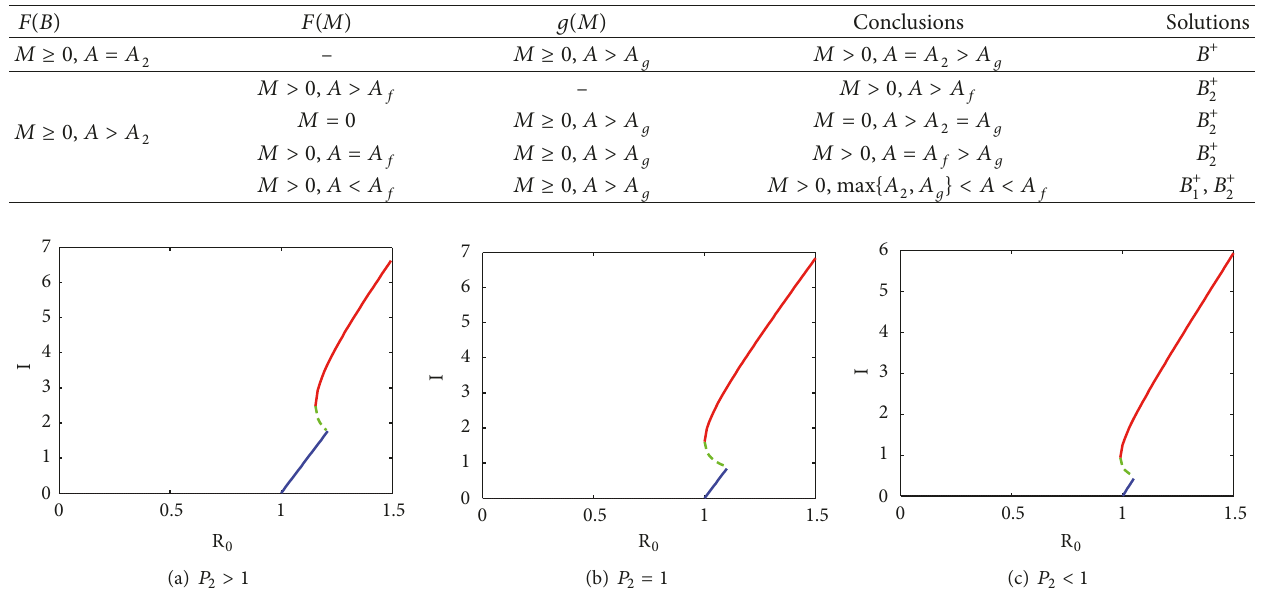
Figure 2: Density of the infected dairy cows as a function of the basic reproduction number with 0 < 𝑀 < 𝑀 𝑔 . The common values of (a), (b), and (c) used for the parameters are as follows: 𝑤 = 3 , 𝑑 = 2 , 𝑐 = 0.8 , 𝛿 = 4 , 𝑞 = 1 , 𝛽 = 0.2 , and 𝑎 = 2 . The different values are (a) 𝑚 = 0.1 , 𝑀 = 0.1 ; (b) 𝑚 = 0.0932 , 𝑀 = 0.0468 ; and (c) 𝑚 = 0.05 , 𝑀 = 0.0135 . The forward bifurcation occurs at 𝑅 backward bifurcation occurs at 𝑅 0 = 1.2101 in picture (a), at 𝑅 0 = 1.1056 in picture (b) and at 𝑅 0 = 1.0567 in picture